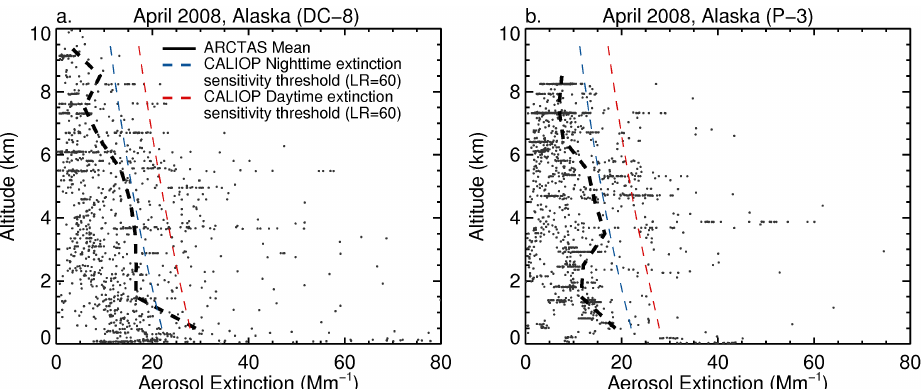
Fig. 6. ARCTAS mean extinction profiles for April 2008 over the AK domain shown in Fig. 4 for the DC-8 (a) and P-3 (b) aircraft platforms. The ARCTAS 1min average measurements are shown with grey dots, whereas their altitude-binned mean is shown with a dashed black line. All measurements are corrected to ambient RH. The CALIOP daytime and nighttime extinction detection thresholds are also shown with a red and blue dashed line respectively, assuming a lidar ratio of 60sr (see text).